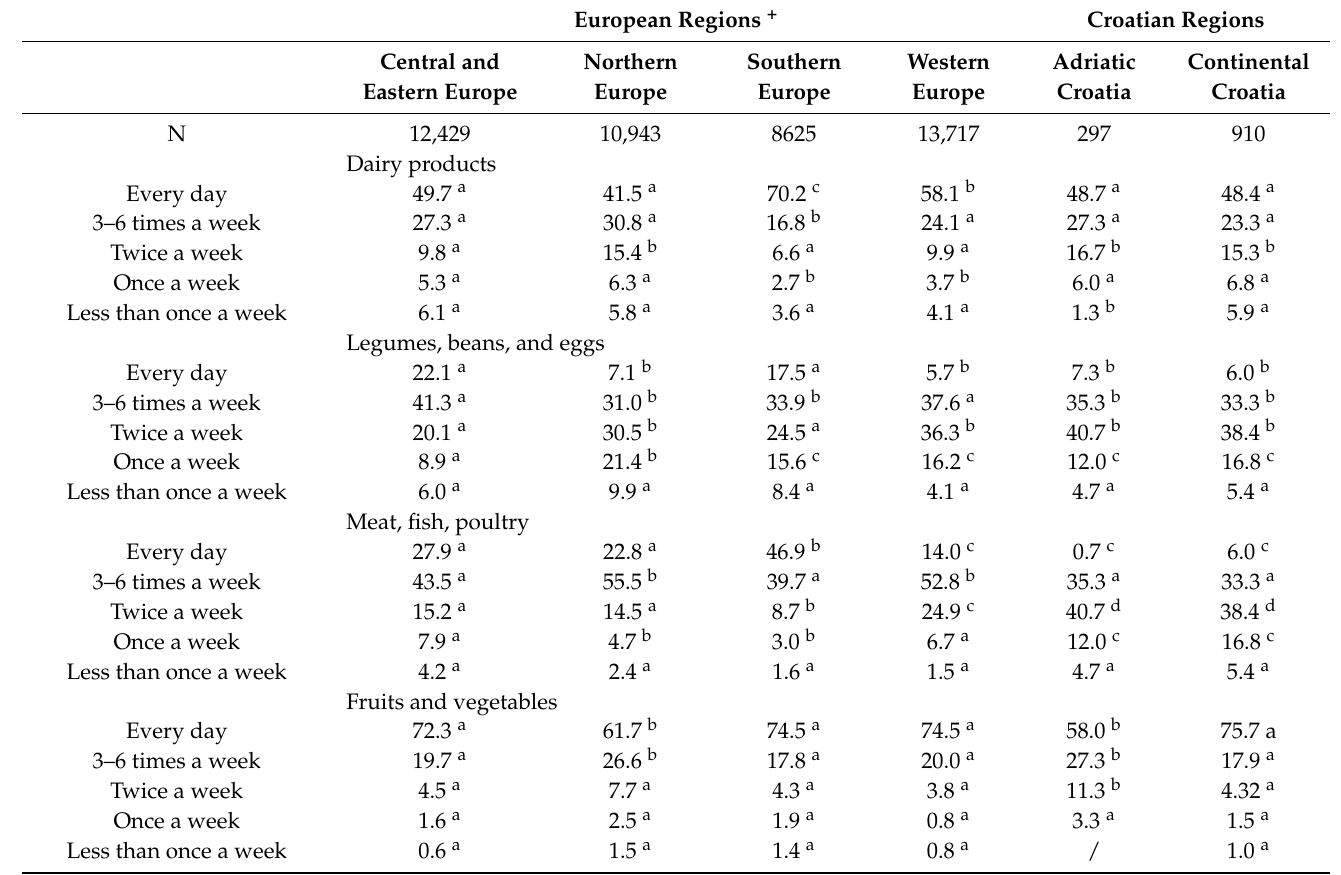
Table A4. Frequency (%) of food consumption from the four main groups with the corresponding number of respondents in four different European